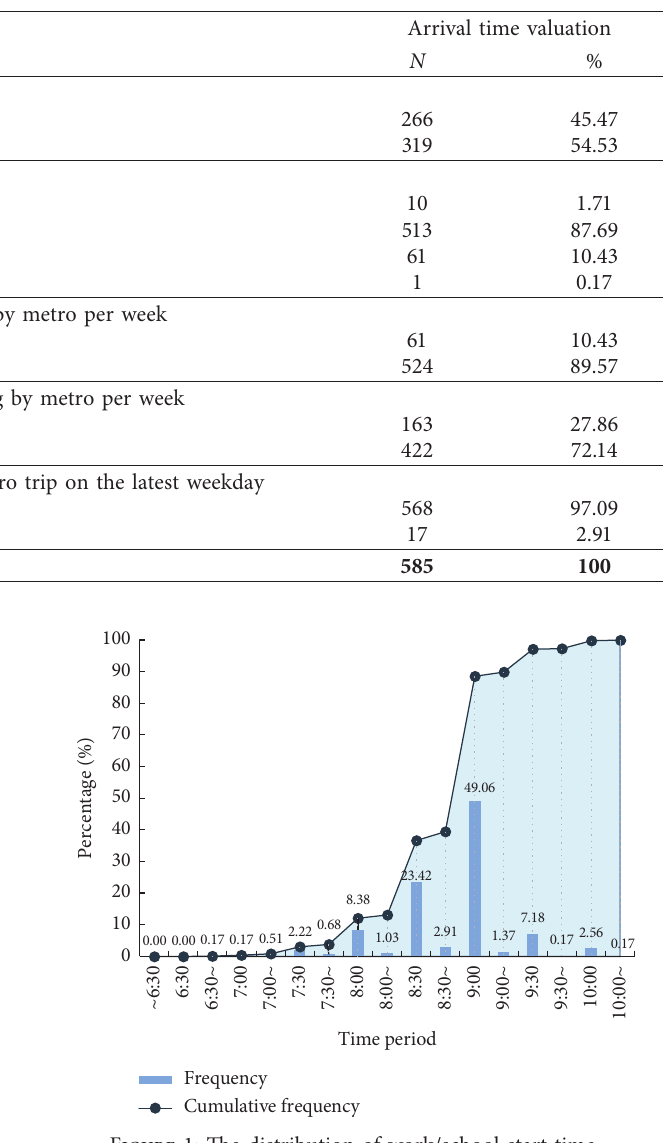
Table 4: Respondents’ socioeconomic and metro usage profile.